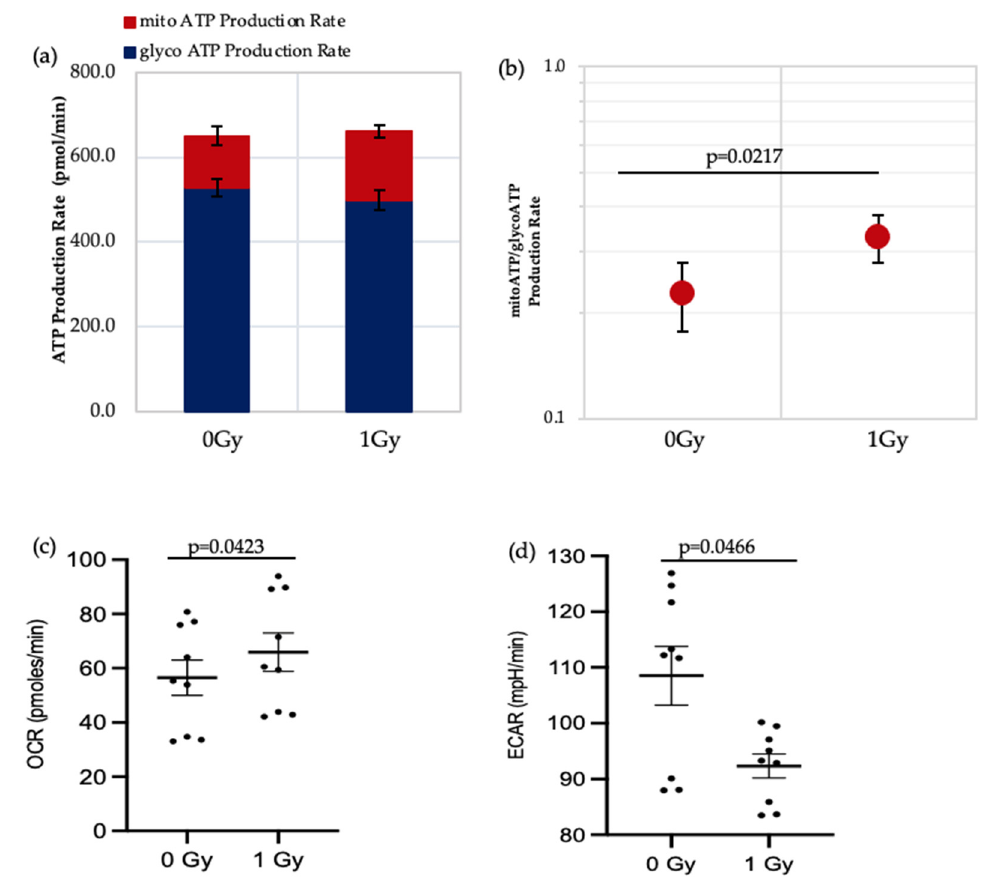
Figure 3. Seahorse XF real-time ATP rate analysis of HSPCs under low O 2 environment. ( a ) Metabolic flux analysis shows increased OXPHOS when HSPCs are exposed to 1 Gy. ( b ) XF ATP rate index calculated from the data in panel a. ( c , d ) OCR: oxygen consumption rate. ECAR: extracellular acidification rate. Student t -test applied. Horizontal lines indicate statistical comparison made. Three independent experiments proceeded ( N = 3; 3 wells/dose/experiment; error bars represent ±SEM).